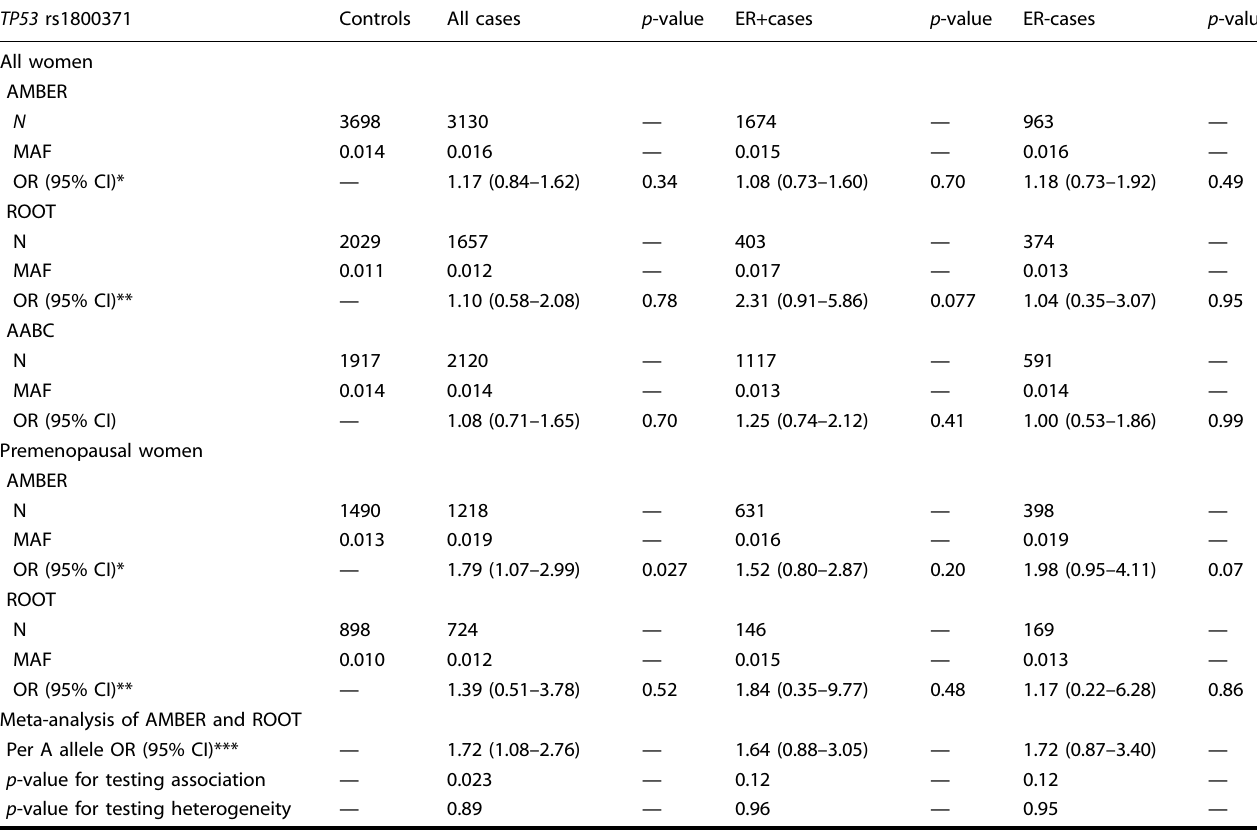
Table 1. Associations between TP53 rs1800371 and breast cancer risk in African-American women in the AMBER, ROOT, and AABC Consortia TP53 rs1800371